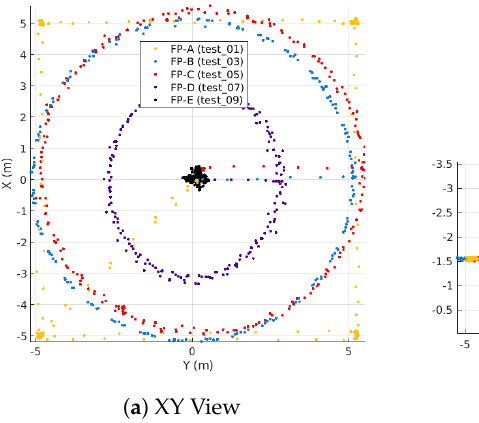
Figure 4. Five outdoor flight